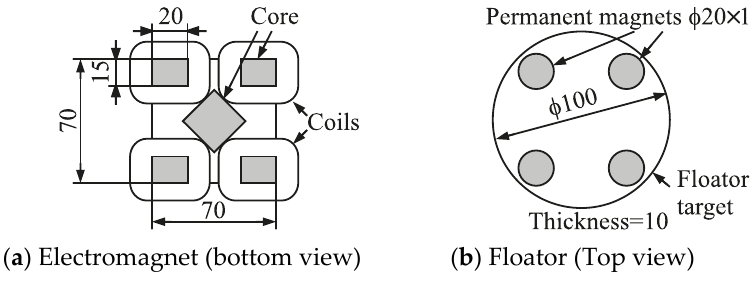
Figure 6. Schematic view of the electromagnet and floator.